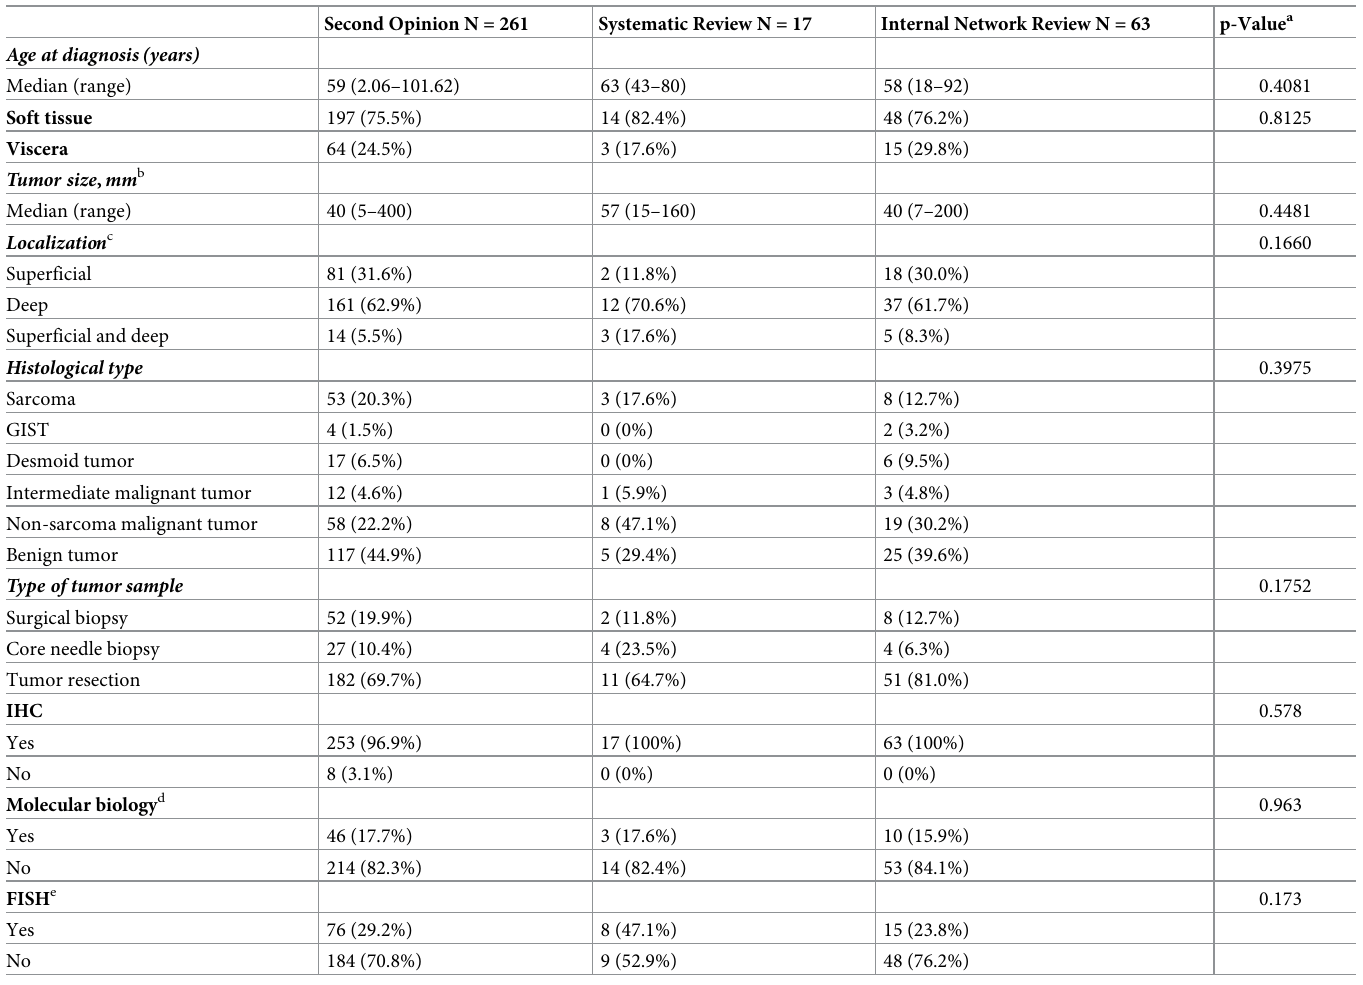
Table 4. Patient and tumor characteristics according to the type of histological review (n =